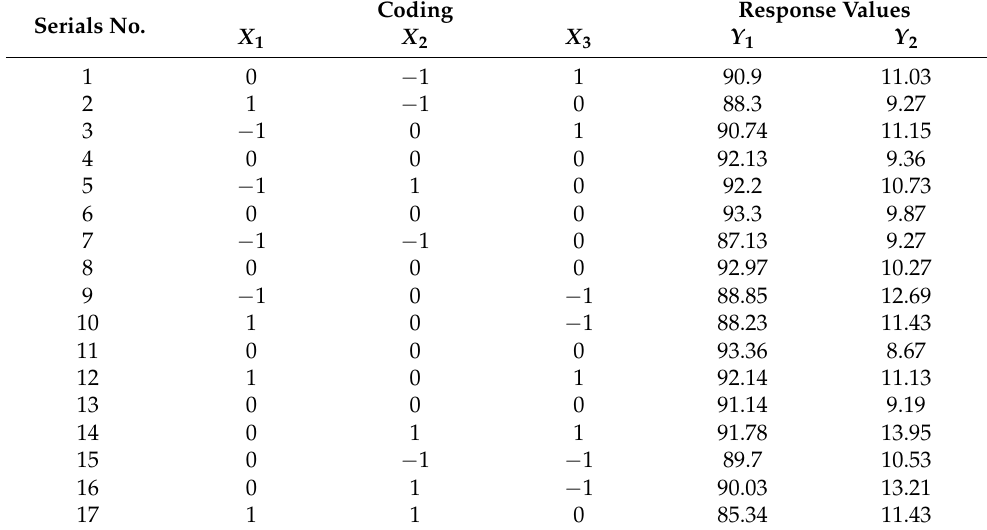
Table 2. Test design and